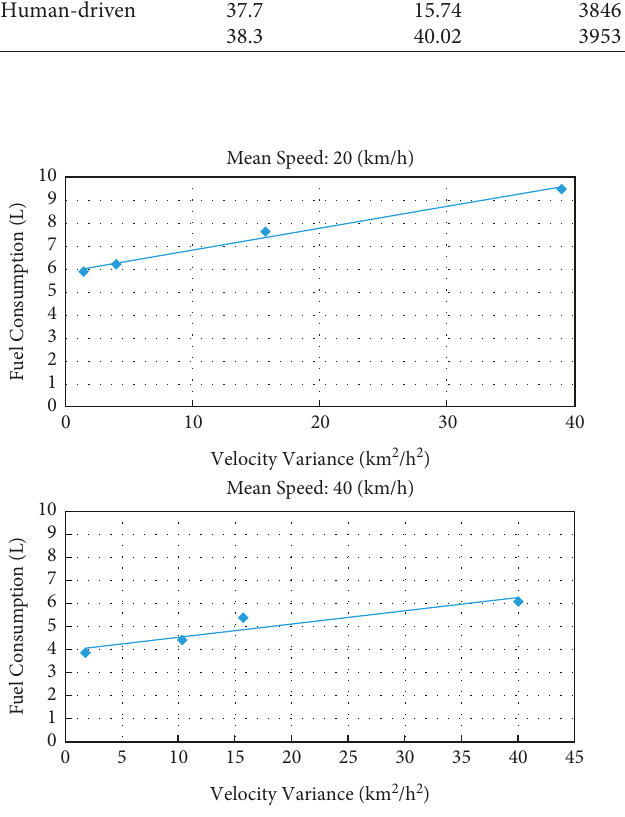
Figure 12: Fuel consumption with velocity variance at speeds of 20km/h and